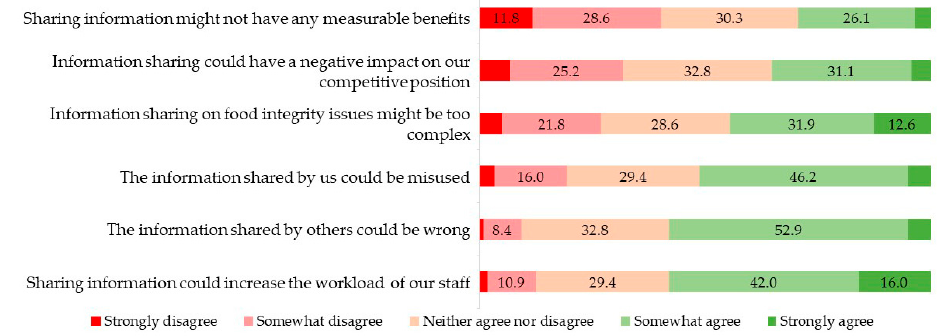
Figure 3. Perceived disadvantages of information sharing to prevent and detect food integrity issues according to food industry actors ( n = 119, %).